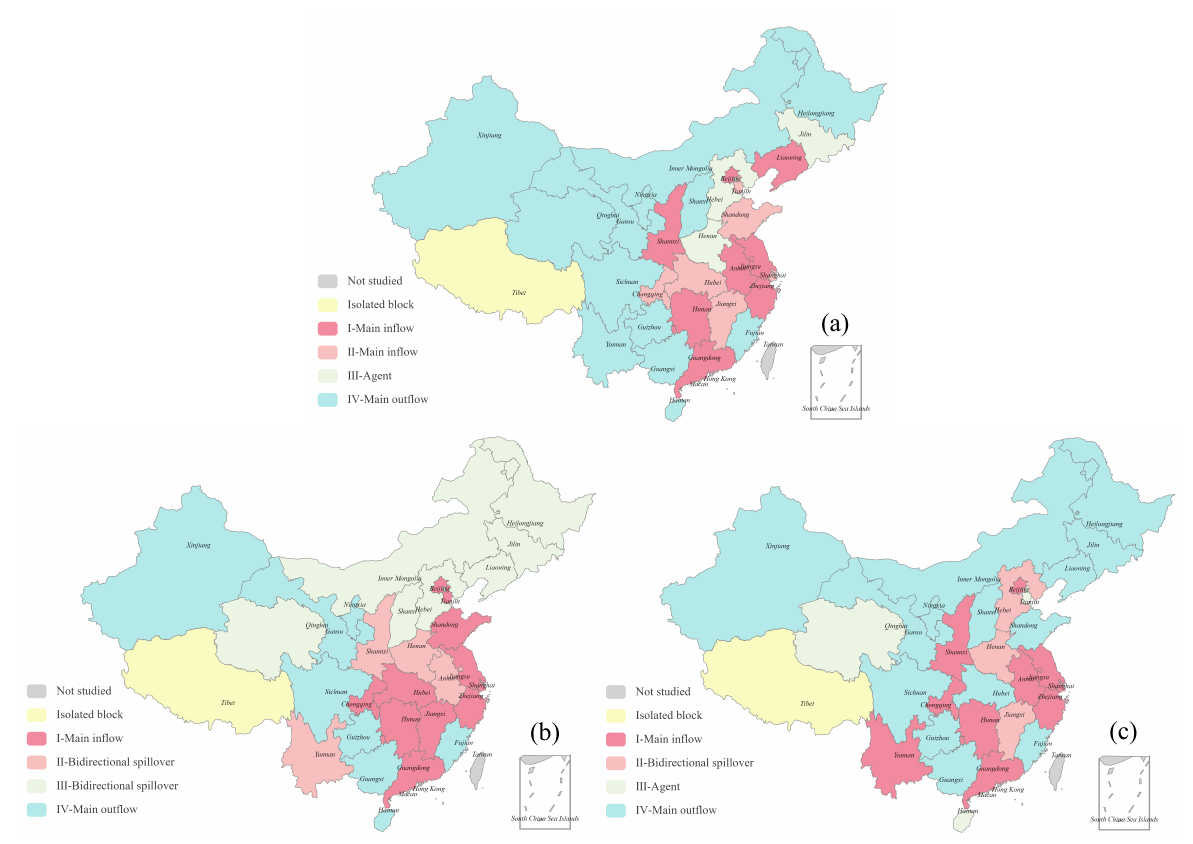
Figure 10. Block division of ECETN. ( a ) Composition of the blocks in China in 2012. ( b ) Composition of the blocks in China in 2015. ( c ) Composition of the blocks in China in